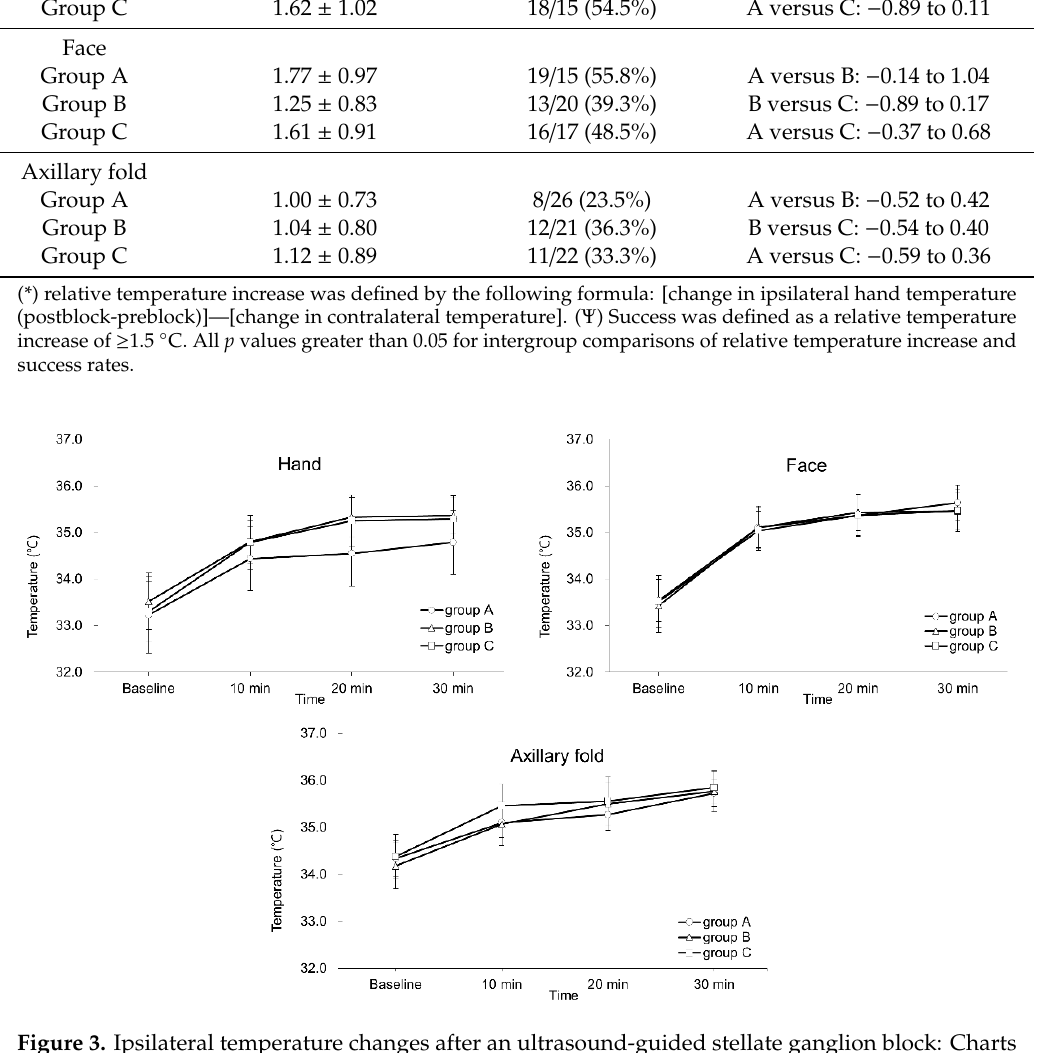
Figure 3. Ipsilateral temperature changes after an ultrasound-guided stellate ganglion block: Charts depict the mean skin temperature changes recorded by time period, for the face, hand and axilla. Groups A, B and C received 4, 6 and 8 mL of 1% lidocaine, respectively. Error bars represent the standard deviation for each data point. Table 1. Baseline Demographic and Clinical Characteristics of Study Participants .